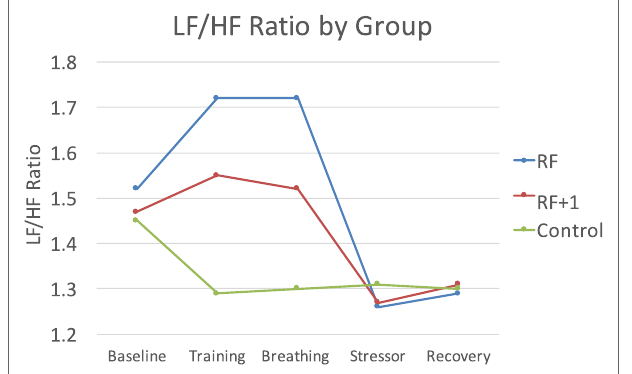
FigUre 2 | The RF and RF + 1 groups showed decreased blood pressure during breathing training compared to the control group. The RF group showed the smallest increase (least reactivity) in blood pressure in response to the stressor compared to the RF + 1 and control groups.